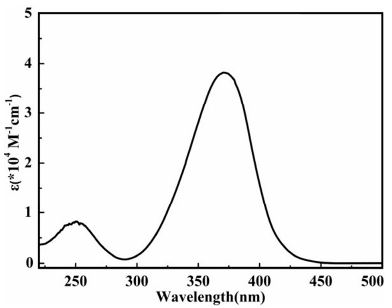
Figure 2. UV-visible absorption spectrum of BFC in acetonitrile. Reproduced with permission of Ref. [221] .